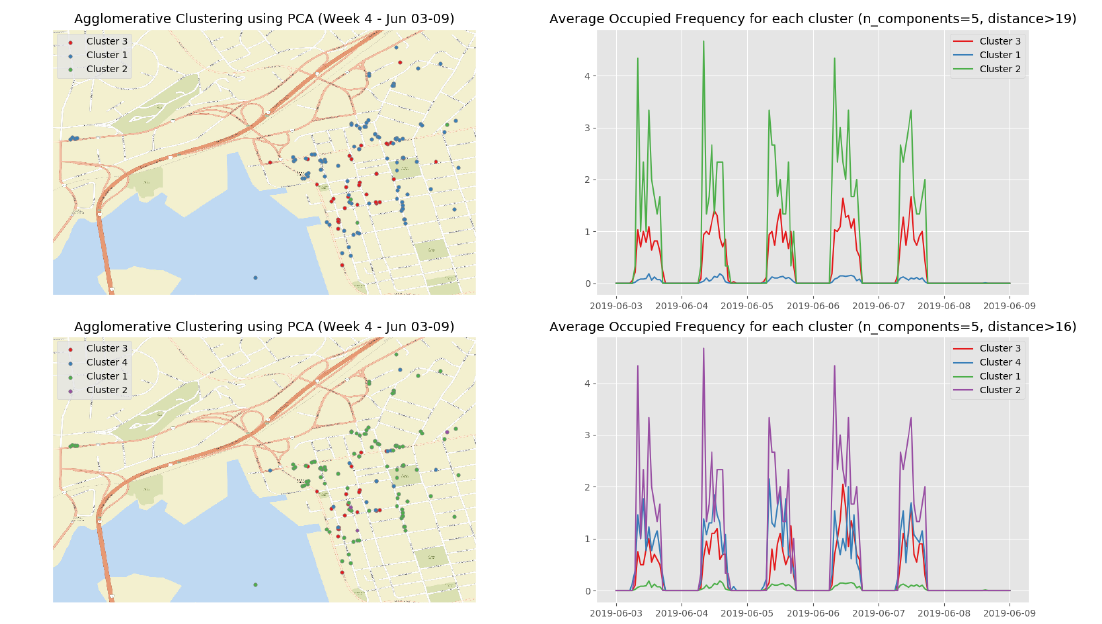
Figure A9. Clustering results using PCA for the 4th